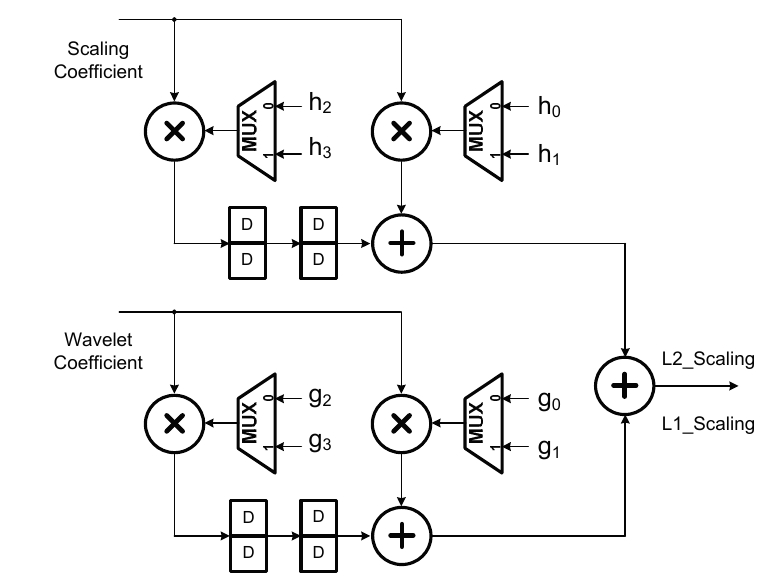
Figure 6. A three level 1D IDWT